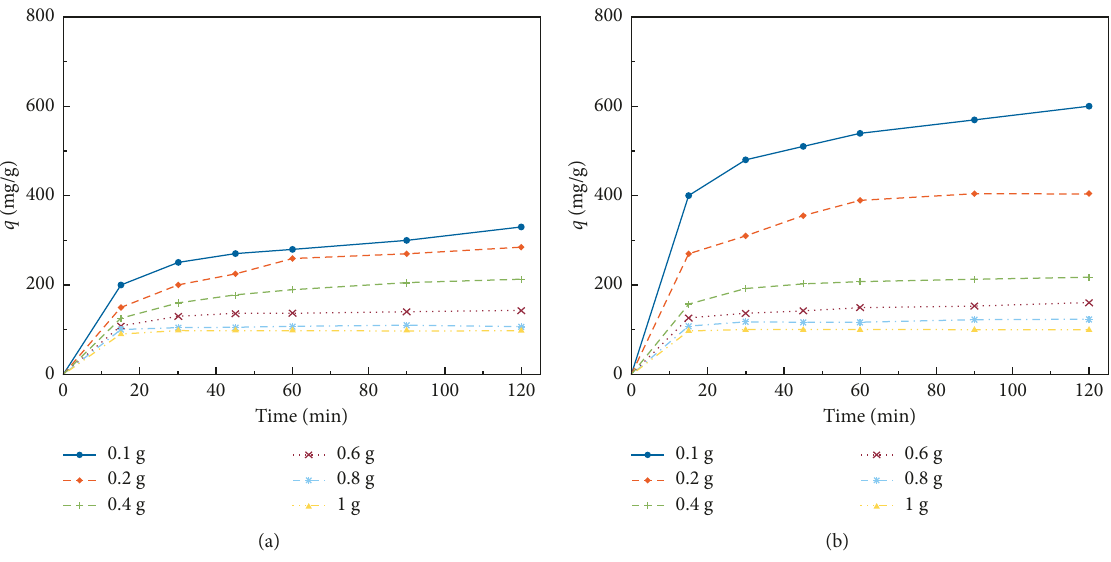
Figure 3: Effect of (a) raw sawdust dose (100mg/L) and (b) chemically treated sawdust dose on dye